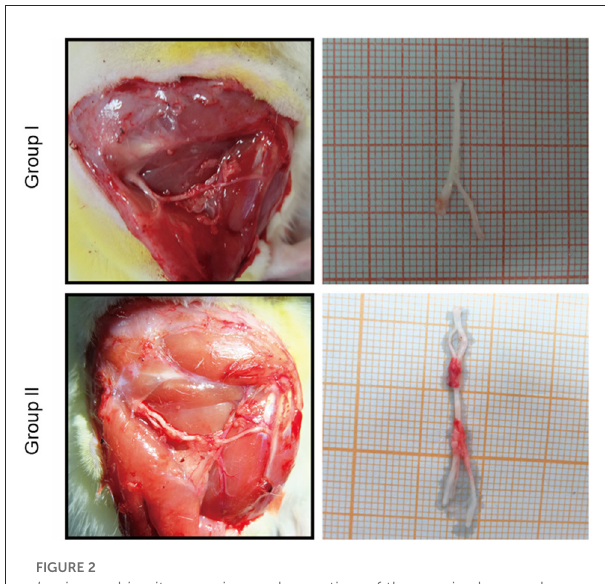
FIGURE2 In vivo and in vitro specimen observation of the repaired nerve. In Group I, only the distal end of the common peroneal nerve was sutured; in Group II, both proximal and distal ends of the common peroneal nerves were sutured.